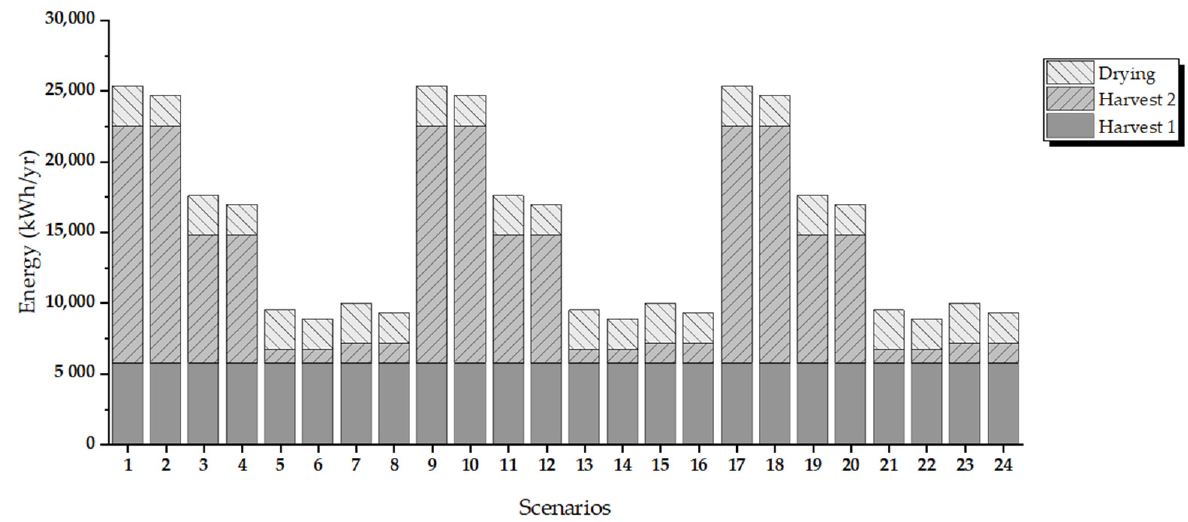
Figure 6. Distribution of energy consumption in the harvesting and drying stages of biomass. All scenarios are fed from the PBR effluent.